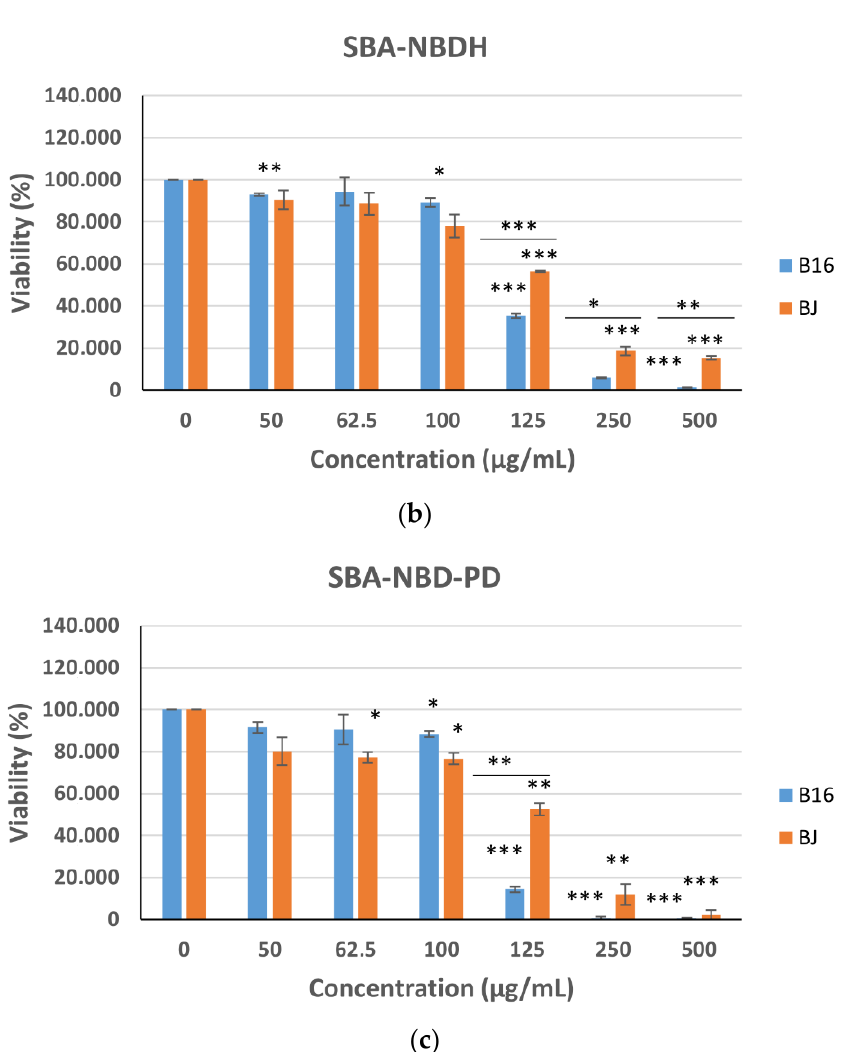
Figure 11. Cytotoxicity of nanoparticles on B16 and BJ cells. Proliferation kinetics of tumor and normal cells at 5 days after exposure to different concentrations of SBA-15 ( a ), SBA-NBDH ( b ), and SBA-NBD-PD ( c ). Data are presented as percentage of untreated control and are shown as mean ± SEM (n = 3). * p < 0.05; ** p < 0.01; *** p < 0.001.